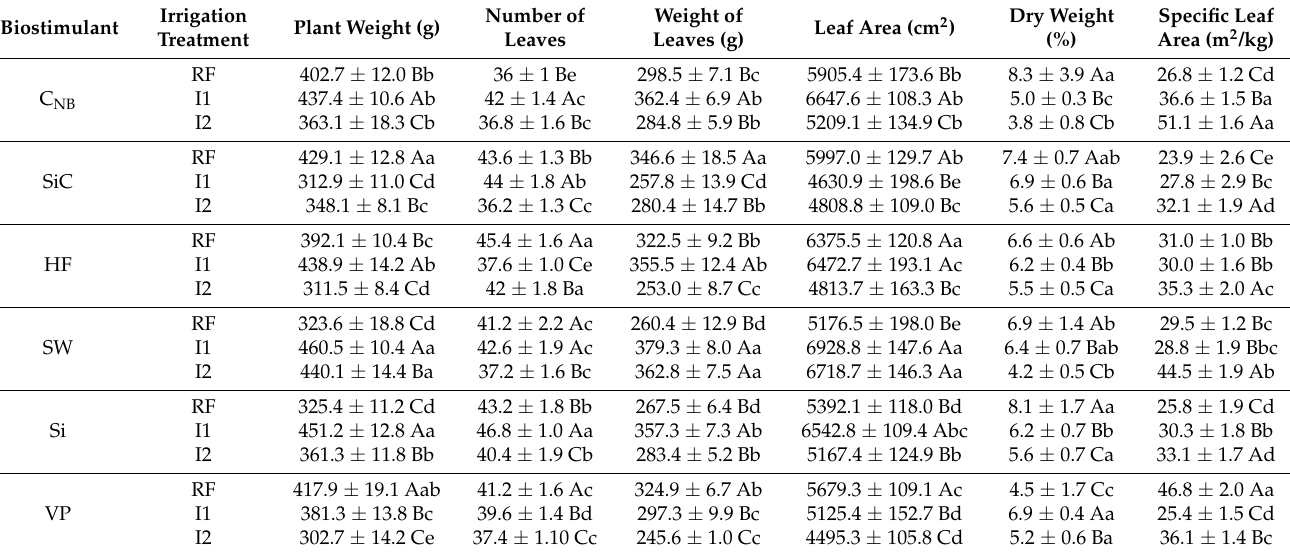
Table 3. Growth-related parameters of Romaine-type lettuce plants concerning the irrigation regime and the biostimulant treatment (means ±